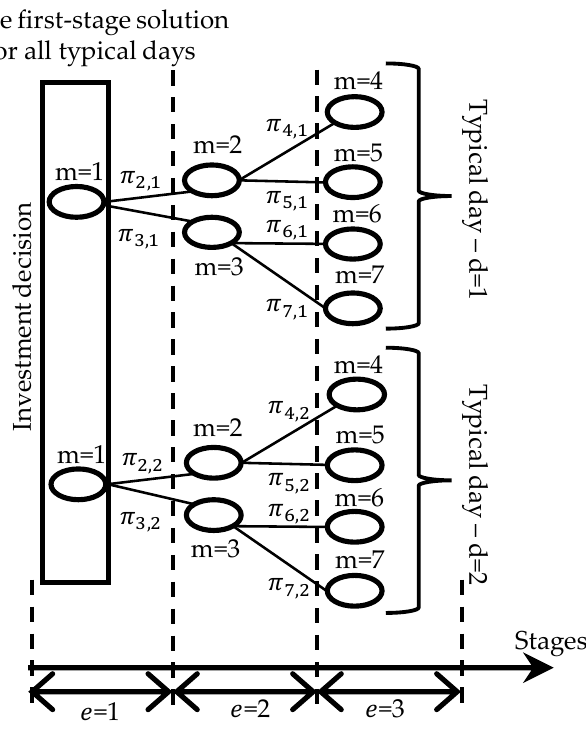
Figure 1. Modeling